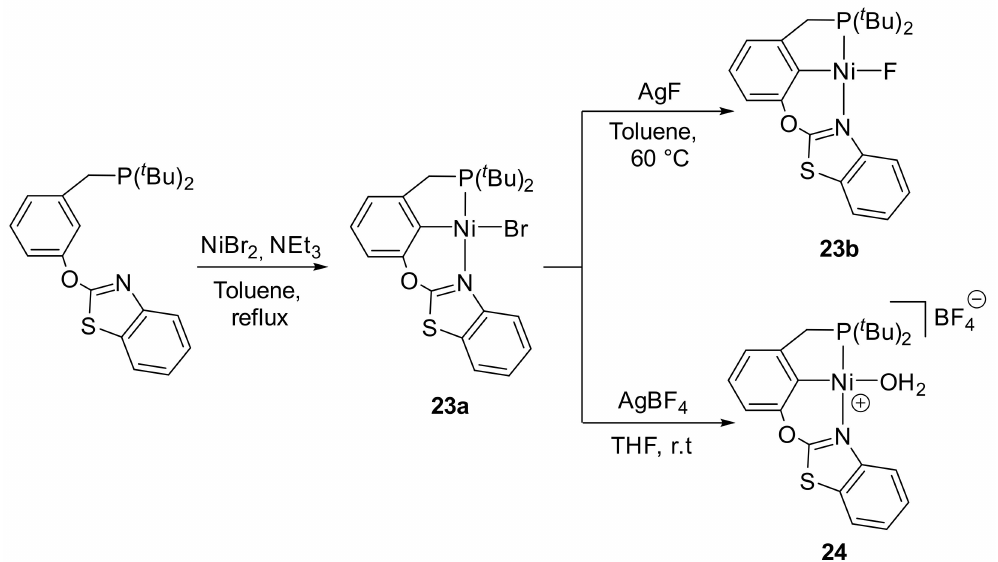
a distortion of the ligand, which is not lying on the P-Ni-N plane (Figure 5).